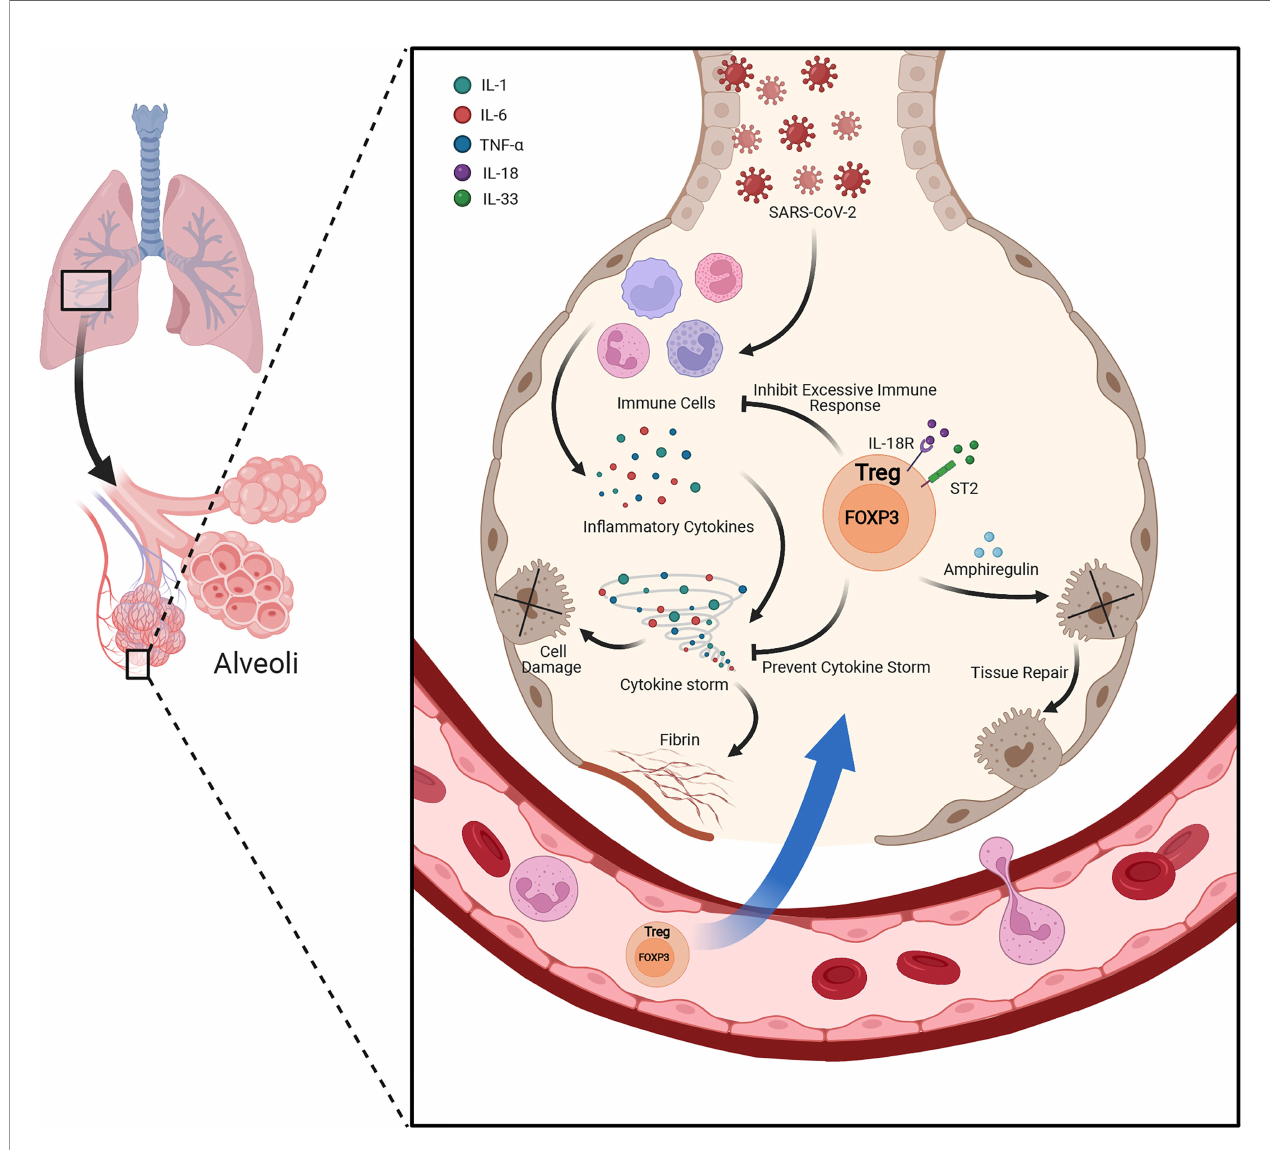
FIGURE 2 | Lung resident Treg plays protective role under acute lung injury. Besides suppressing the excessive in fl ammatory response and keeping immune tolerance under the condition of acute lung injury, lung resident Tregs also produce Amphiregulin under the stimulation of IL-18 or alarmin IL-33 during lung injury by viral infection. Amphiregulin is crucial for Treg cell-mediated tissue